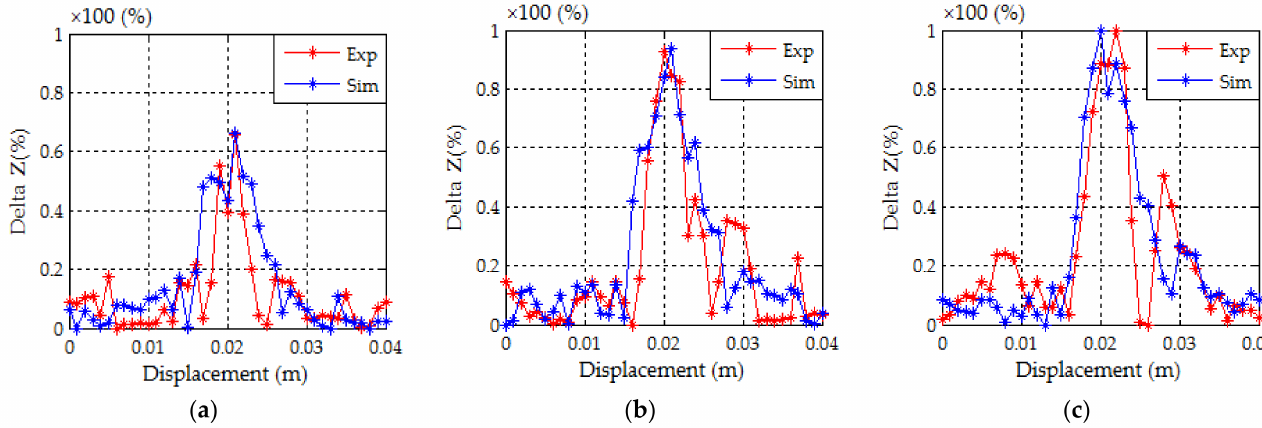
Figure 16. Impedance variation in (%) at 80 kHz with ( a ) depth = 0.3 mm, ( b ) depth = 0.5 mm, and ( c ) depth = 1